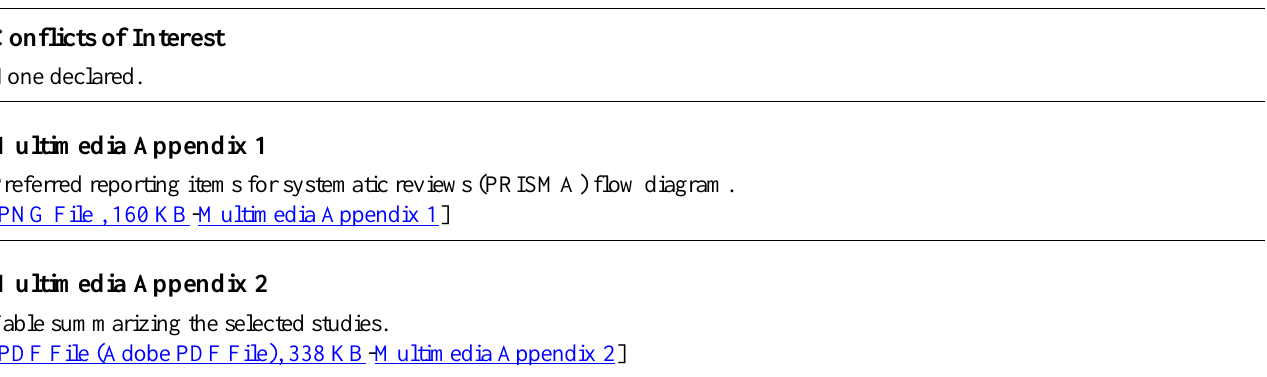
Table summarizing the selected